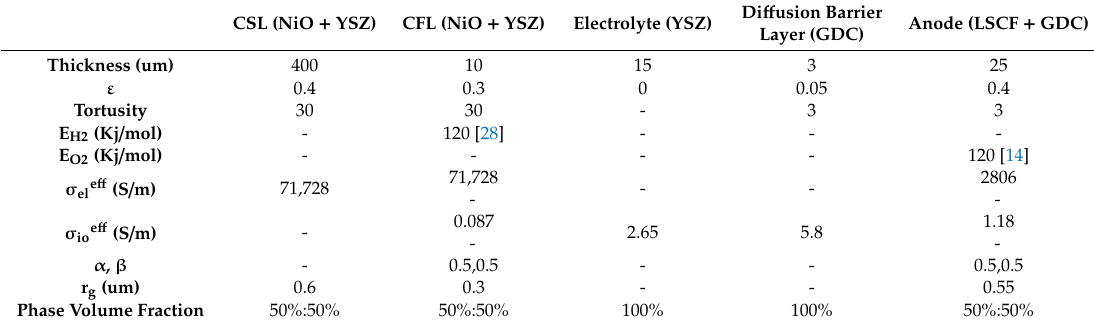
Table 1. Basic model parameters used in the standard cell